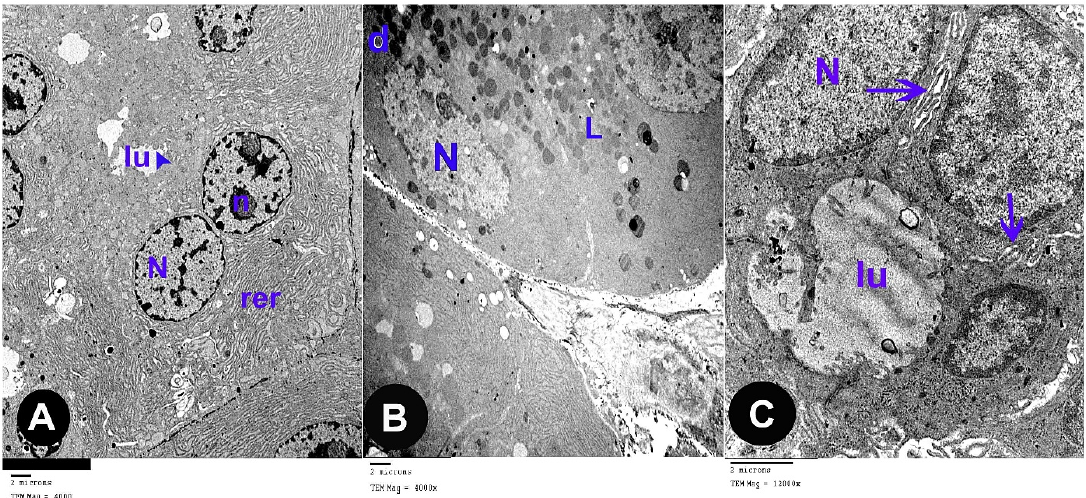
Figure 3. Electron microscope sections in parotid tissue of albino rats of the control group: ( A ) serous acini with pyramidal shaped cells which contained euchromatic rounded nuclei (N), prominent nucleoli (n) and rough endoplasmic reticulum (rer). Microvilli (arrow head) of the acinar cells appeared at the luminal surface (lu). ( B ) Electron-dense granules (d) and electron-lucent granules (L) ( C ) Serous acini with their lumen (lu); they are lined by pyramidal shaped cells with euchromatic nuclei (N) and intact basement membrane with interdigitations (arrow).